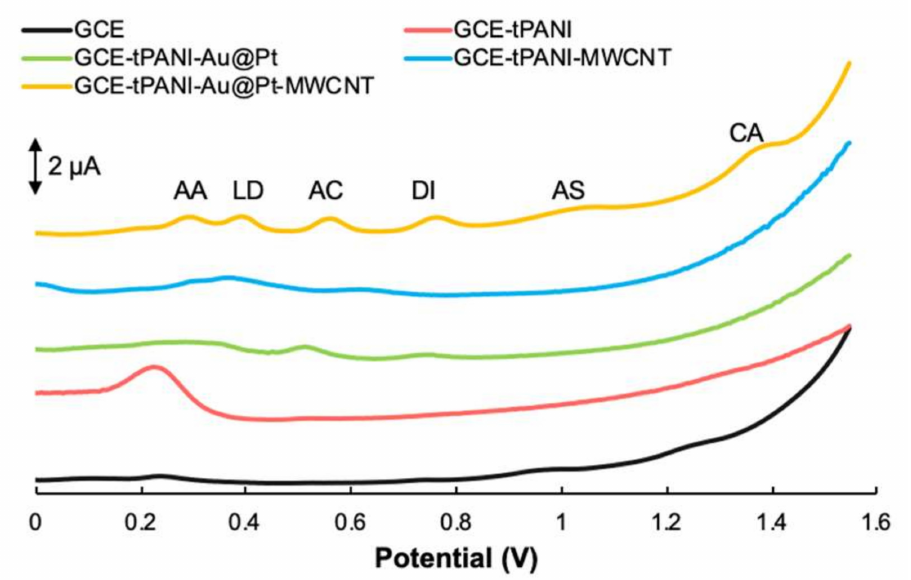
Figure 5. Differential pulse voltammograms for the electrochemical oxidation of ascorbic acid (AA) (150 µ M), levodopa (LD) (15 µ M), acetaminophen (AC) (15 µ M), diclofenac (DI) (15 µ M), acetylsalicylic acid (AS) (150 µ M), and caffeine (CA) (150 µ M) at the blank GCE (black line), tPANI- modified GCE (red line), tPANI-Au@Pt-modified GCE (green line), tPANI-MWCNT-modified GCE (blue line), and tPANI-Au@Pt-MWCNT-modified GCE (yellow line) in 0.5 M PBS (pH 3.0).